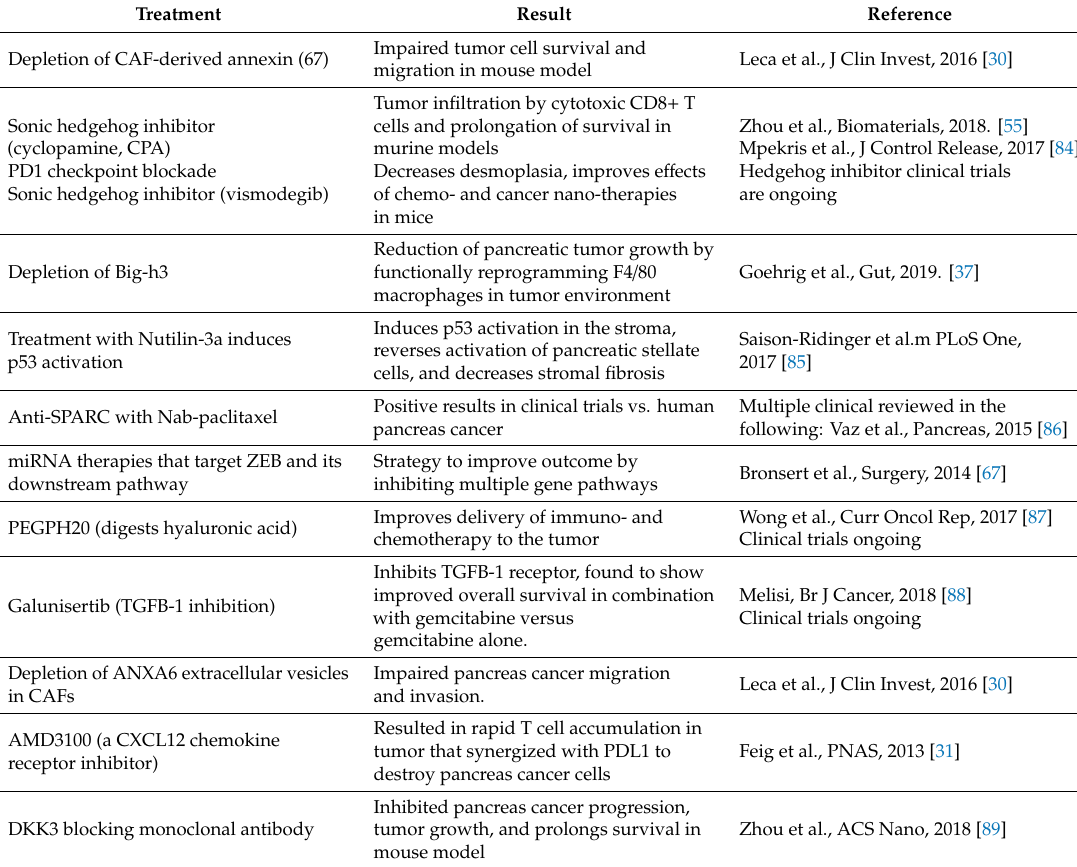
Table 3. Anti-CAF treatment strategies and results in experimental